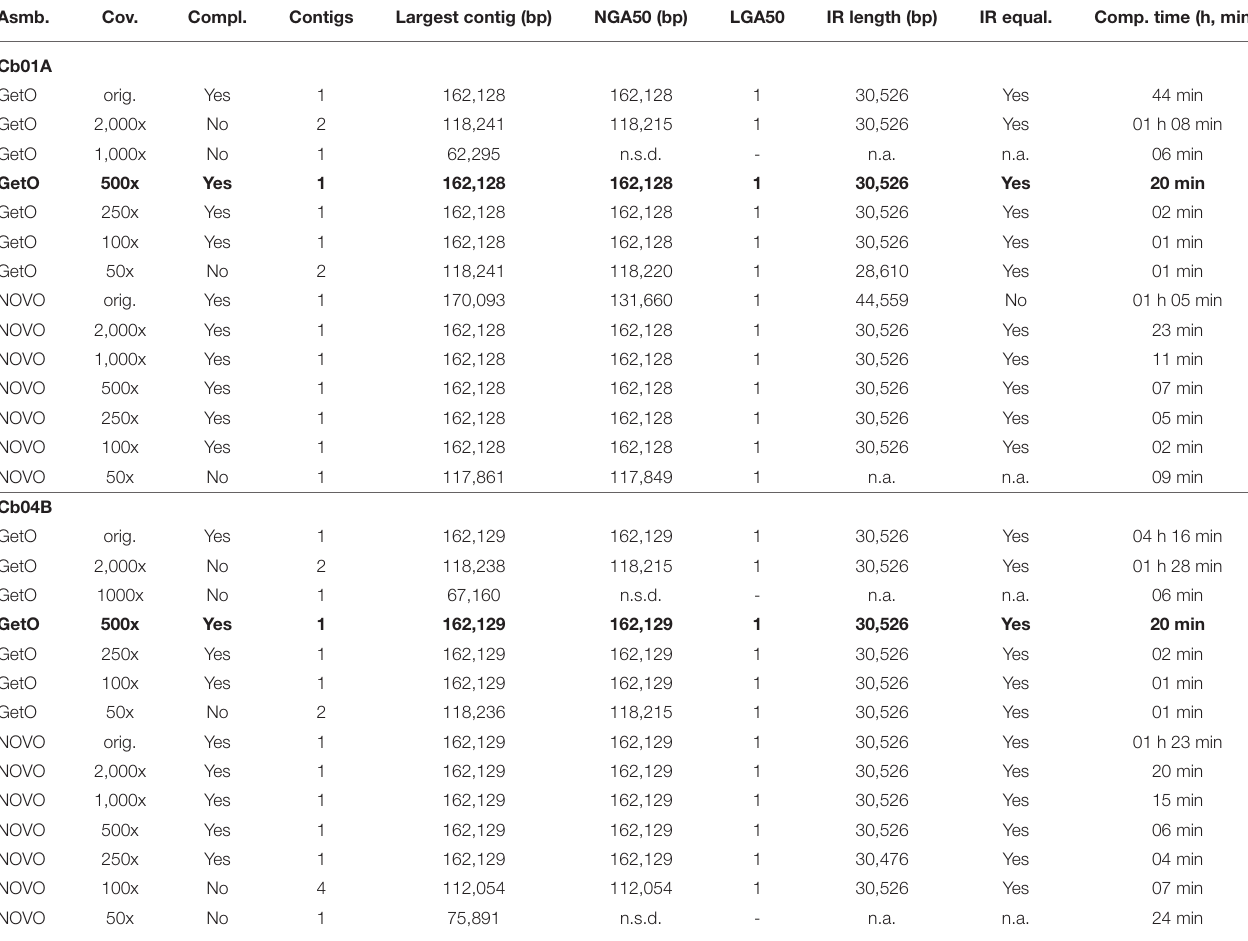
TABLE 2 | Assembly statistics for the plastid genomes of the two individuals of C. bakuense under study regarding the impact of different levels of sequencing coverage. Asmb.